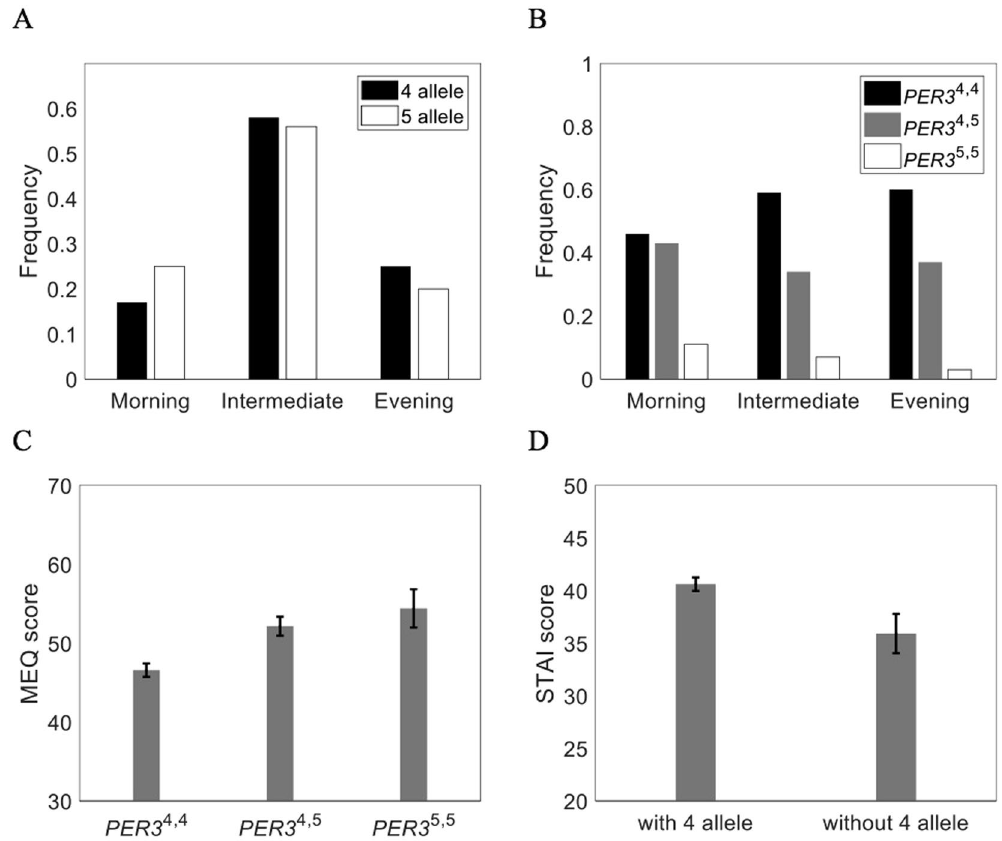
Figure 2. Associations of the PER3 length polymorphism (VNTR) with circadian chronotype and anxiety. ( A ) Frequencies of 4- and 5-repeat alleles in morning-type ( n = 46), intermediates ( n = 136), and evening-type ( n = 62) self-reported chronotypes. The frequency of the PER3 4 allele is higher in evening-types and lower in morning-types (OR = 0.52 95% CI = 0.280–0.975, p = 0.042). ( B ) Frequencies of the PER3 VNTR genotypes in each chronotype. Per3 4,4 homozygotes are less frequent in morning-types ( χ 2 = 5.71, df = 1, p = 0.017) and PER3 5,5 homozygotes are less frequent in evening-types ( χ 2 = 40.90, df = 1, p < 0.001). C)Average self-reported MEQ scores ( ± SD) are lower for PER3 4,4 homozygotes than for PER3 4,5 or PER3 5,5 types ( F(2, 242) = 9.98, p < 0.001). D) Average trait anxiety scores ( ± SD) are higher in individuals carrying a PER3 4 allele ( t = 2.12, df = 242, p =